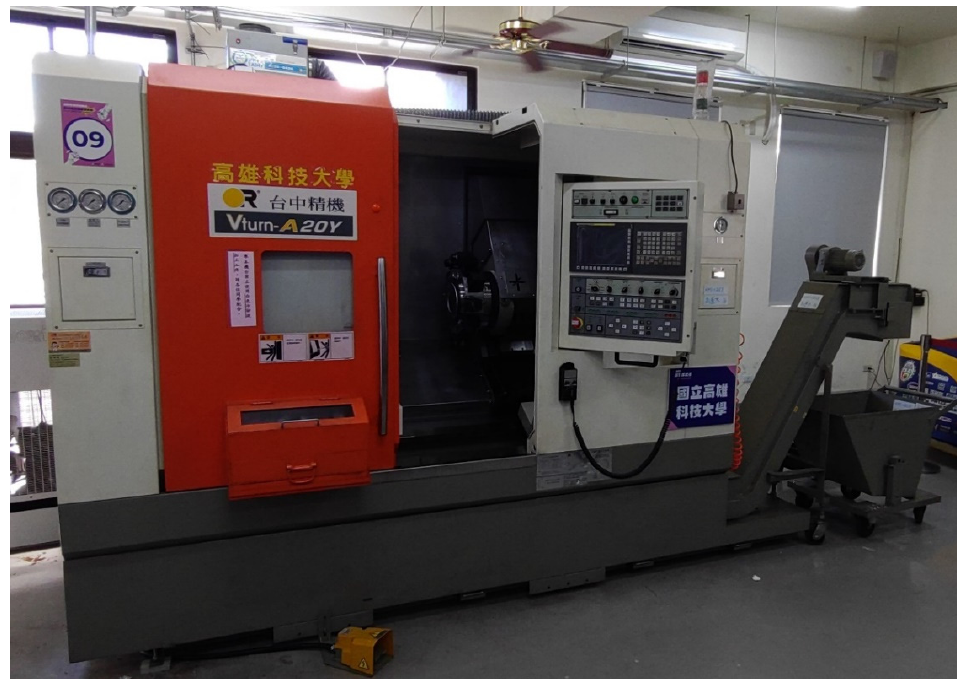
Figure 4. Vturn-A20YCV CNC turning-milling machine.